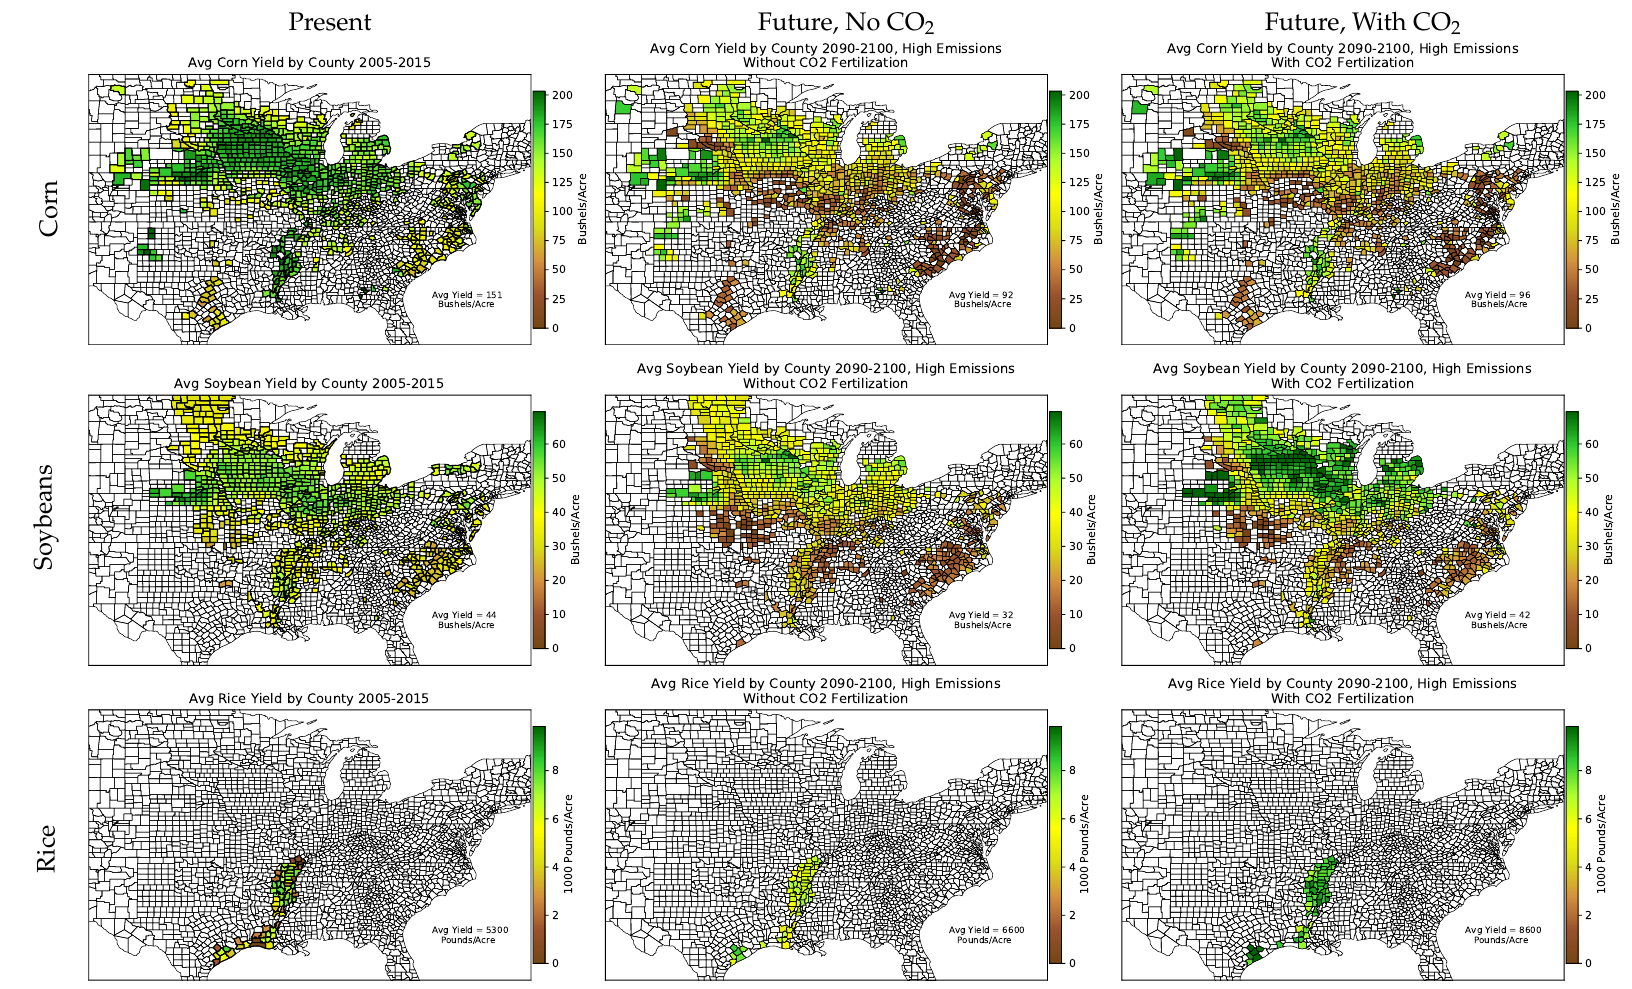
Figure 9. Crop yield of corn (top), soybeans (middle), and rice (bottom) for 2005–2015 (left), 2090–2100 without CO 2 fertilization (center), and 2090–2100 with CO 2 fertilization (right). Crop predictions are for a high-emissions scenario without future technology